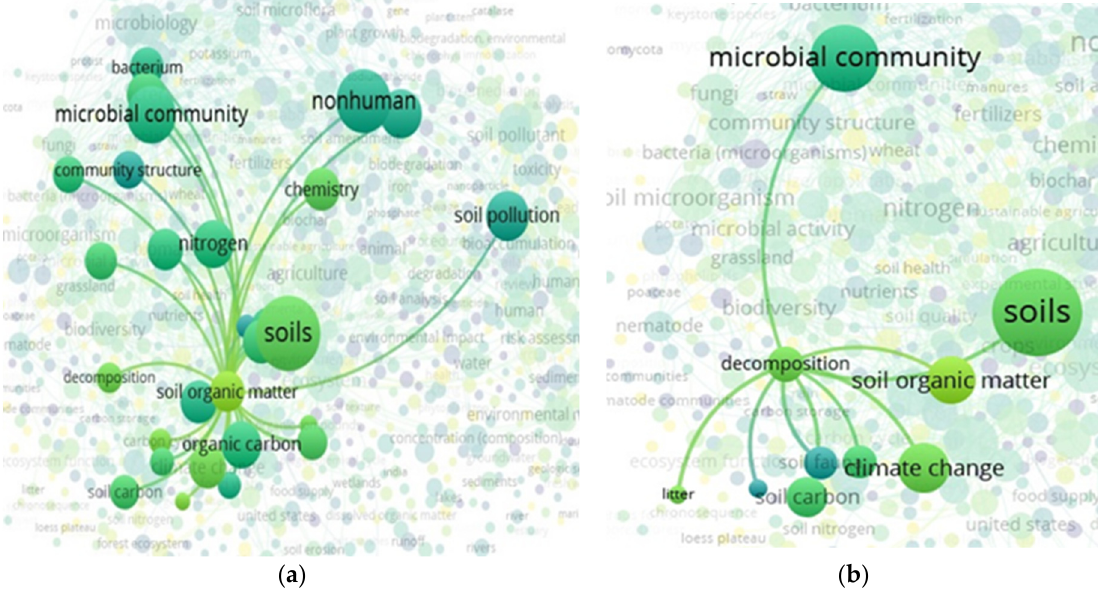
Figure 5. Analyzing Scopus results with the VOSviewer. The organic matter ( a ) and the decomposition ( b ) paradigm.